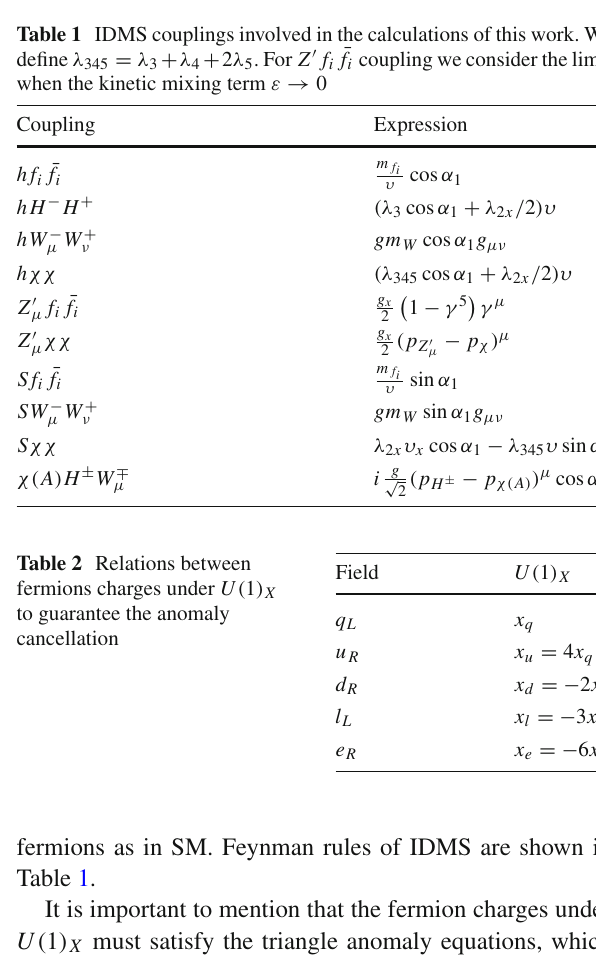
Table 1 IDMS couplings involved in the calculations of this work. We define λ